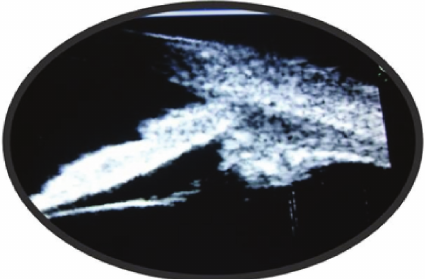
Figure 2: UBM picture showing the ciliary body mass.